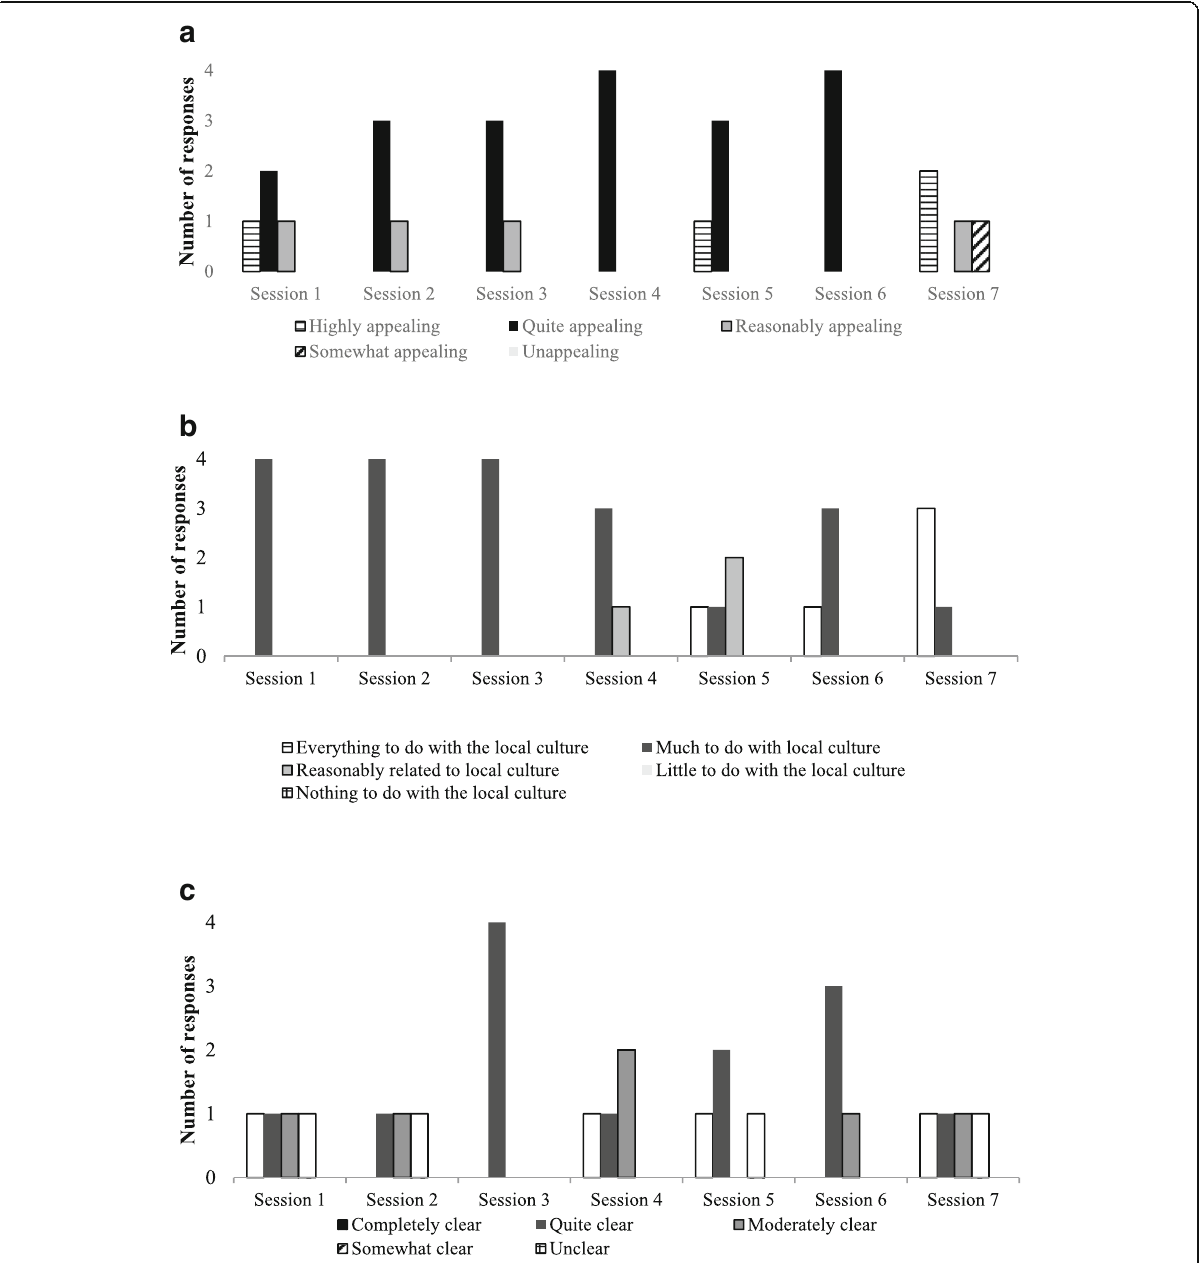
Fig. 1 External observers ’ perceptions. a Appeal of the procedures, b Cultural relevance of the procedures, and c Clarity of the procedures. ( N : session 1=6 observations; session 2=5 observations; session 3=3 observations; session 4=4 observations; session 5=3 observations; session 6=4 observations; session 7=4